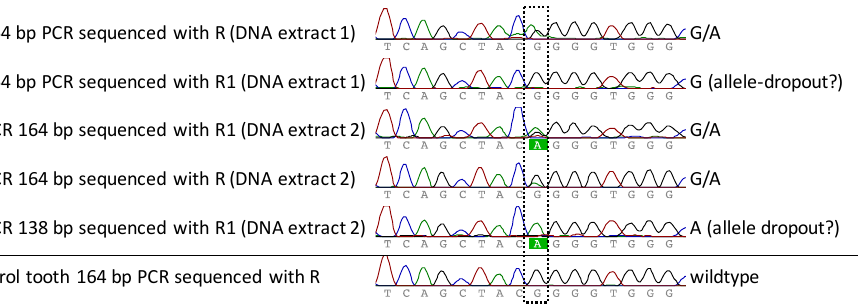
Figure 3. Sequencing results of multiple PCRs from the premolar of the achondroplastic skeleton, as well as the analysis of a control tooth. Rows 1–5: Two independent DNA extracts of the premolar were analyzed for the presence of a mutation. Two different long PCR-systems as well as two sequencing primers were used for analysis. In two PCRs, only the wildtype G or the mutant allele A was observed, indicating allelic-dropout as the G/A was detected in the other three PCRs. The analyzed control tooth resulted in the expected wildtype.